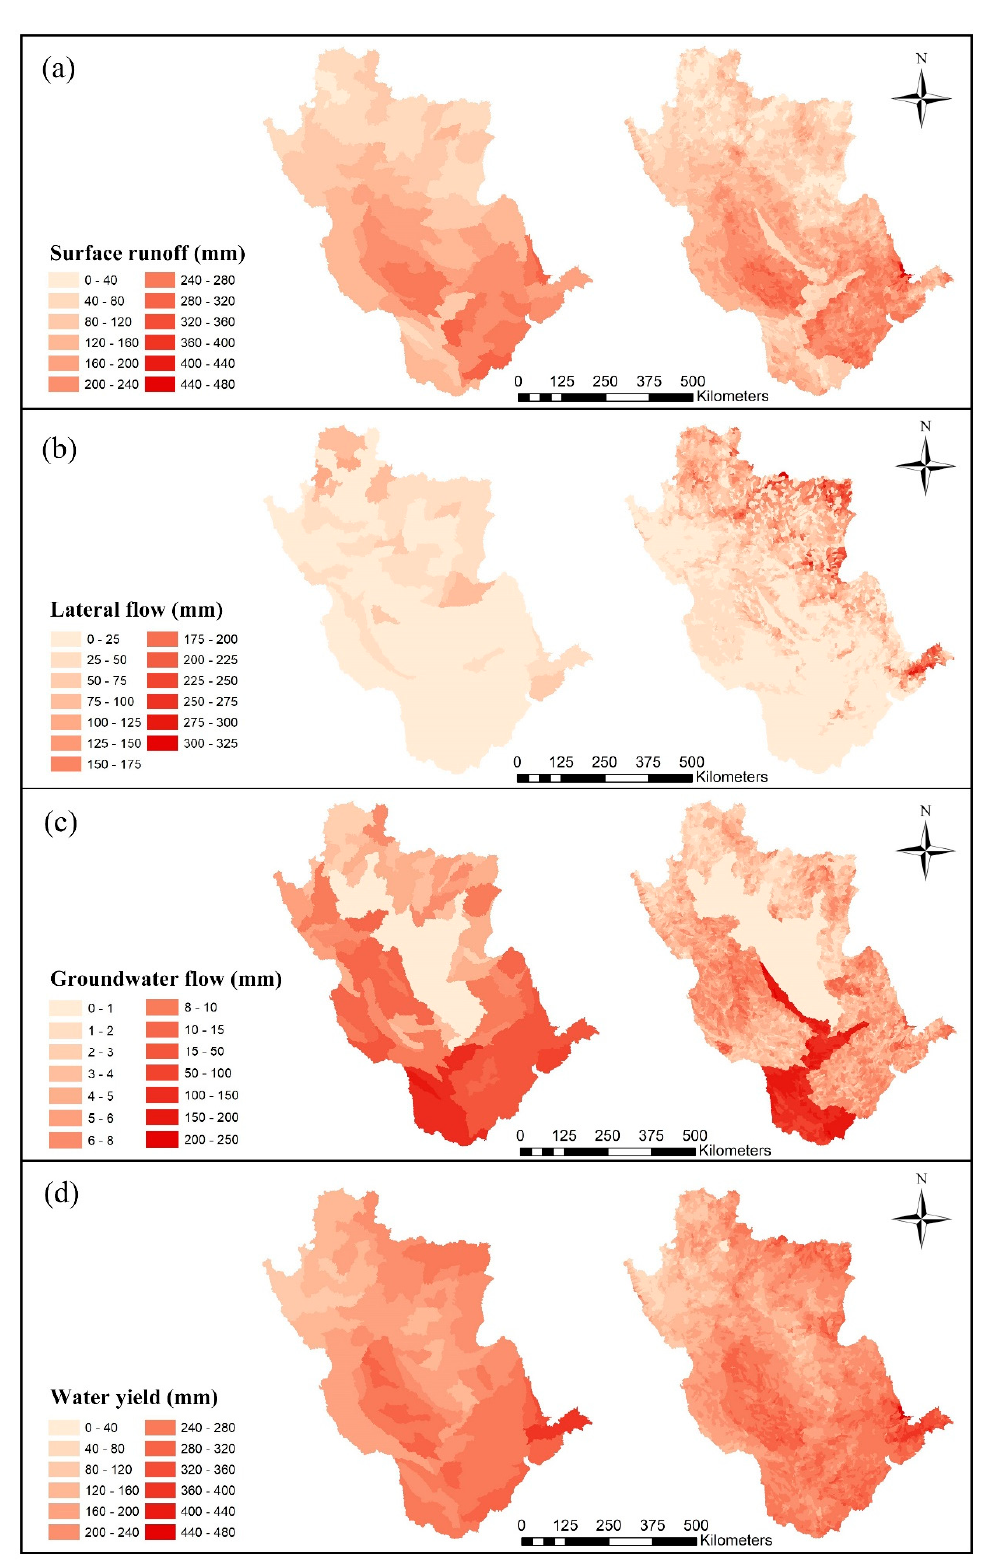
Figure 5. Spatial output of annual averages during 1983 to 2005 for Hydrologic Unit Code (HUC) 8 scenario within 8-digit subbasins ( left ) and for New-HUC12 scenario within 12-digit subbasins ( right ): ( a ) surface runoff; ( b ) lateral flow; ( c ) groundwater flow; and ( d ) water